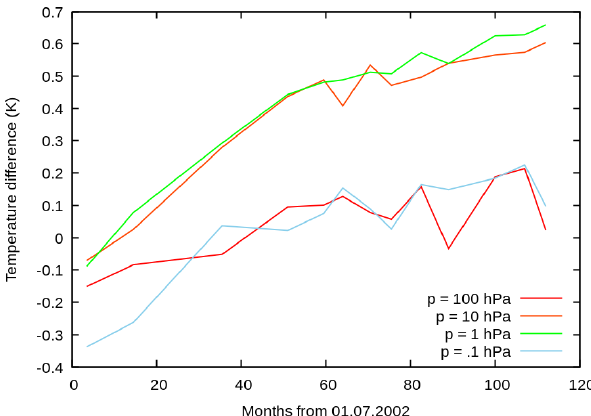
Figure 23. Time dependence of the difference between orbit av- erage temperature values, at the four pressure levels indicated in the key, retrieved (with the ORM V8) using L1b products with and without the NL correction implemented. 14 selected couples of L1b products (from October 2002 to October 2011), generated for this purpose, were